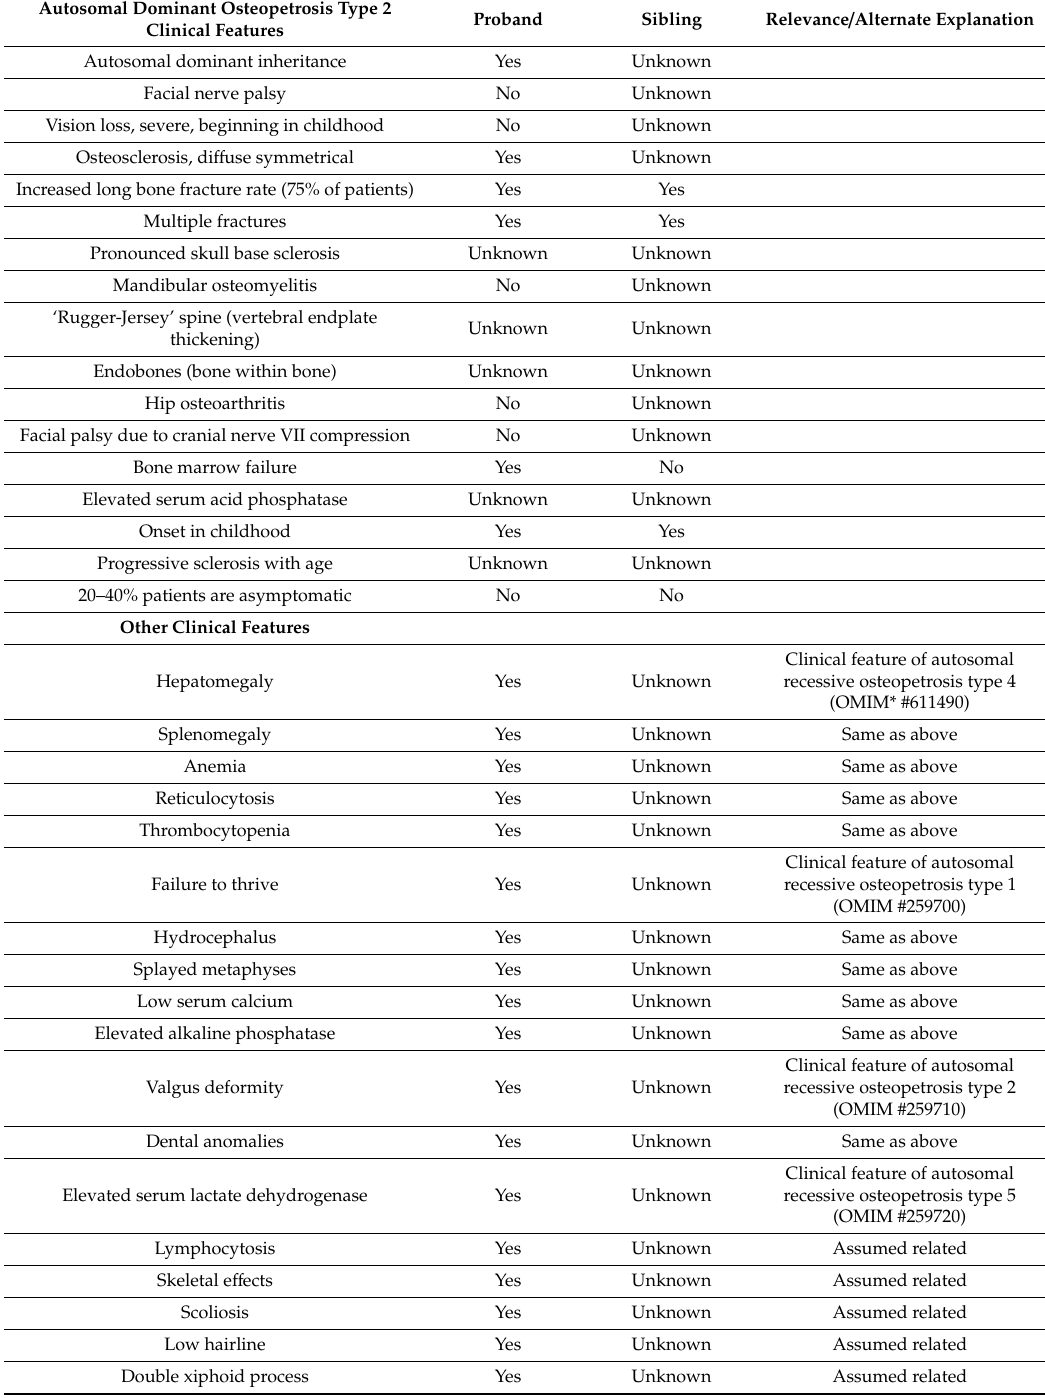
Table 1. Phenotypic features of the proband associated with osteopetrosis autosomal dominant form (ADO) type